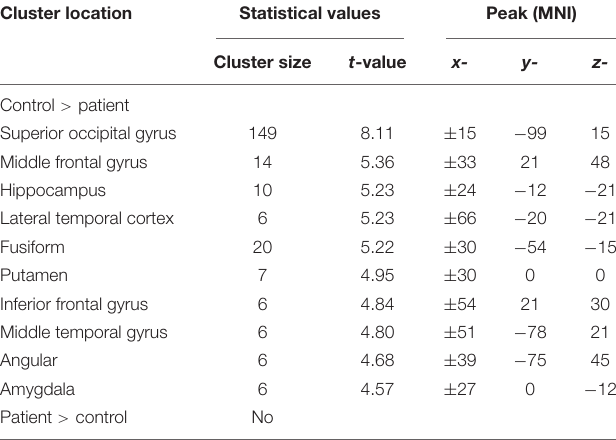
TABLE 2 | Significant group differences in voxel-mirrored homotopic connectivity